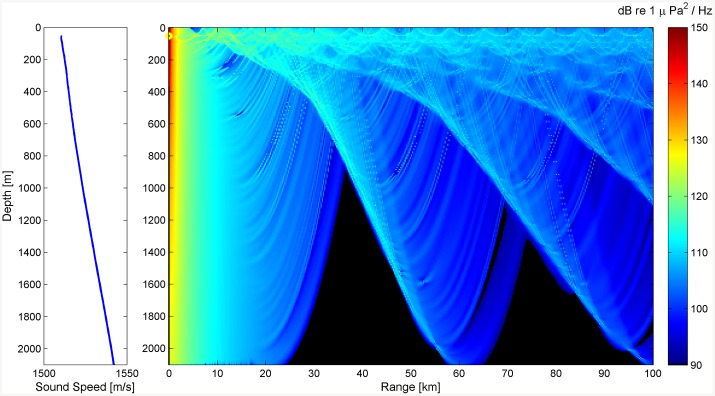
Transmission loss model.Results of BELLHOP incoherent transmission loss model of a 20 Hz signal emitted at a depth of 50 m (SL = 189 dB re 1 μPa at 1 m) [66]. The lower limit of the amplitude transmission is set to 90 dB (black area), which represents the baseline noise value at 20 Hz in the area.